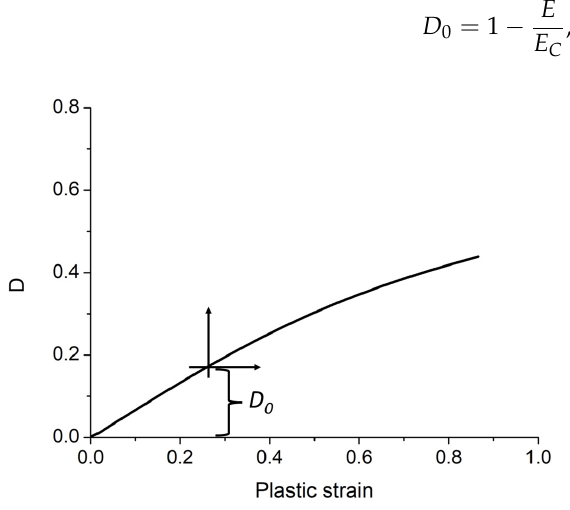
Figure 5. The pre-damage D 0 derived from the tensile tests is subtracted from the ultimate damage measured at failure for the compact material to obtain the effective limit damage leading to rupture.